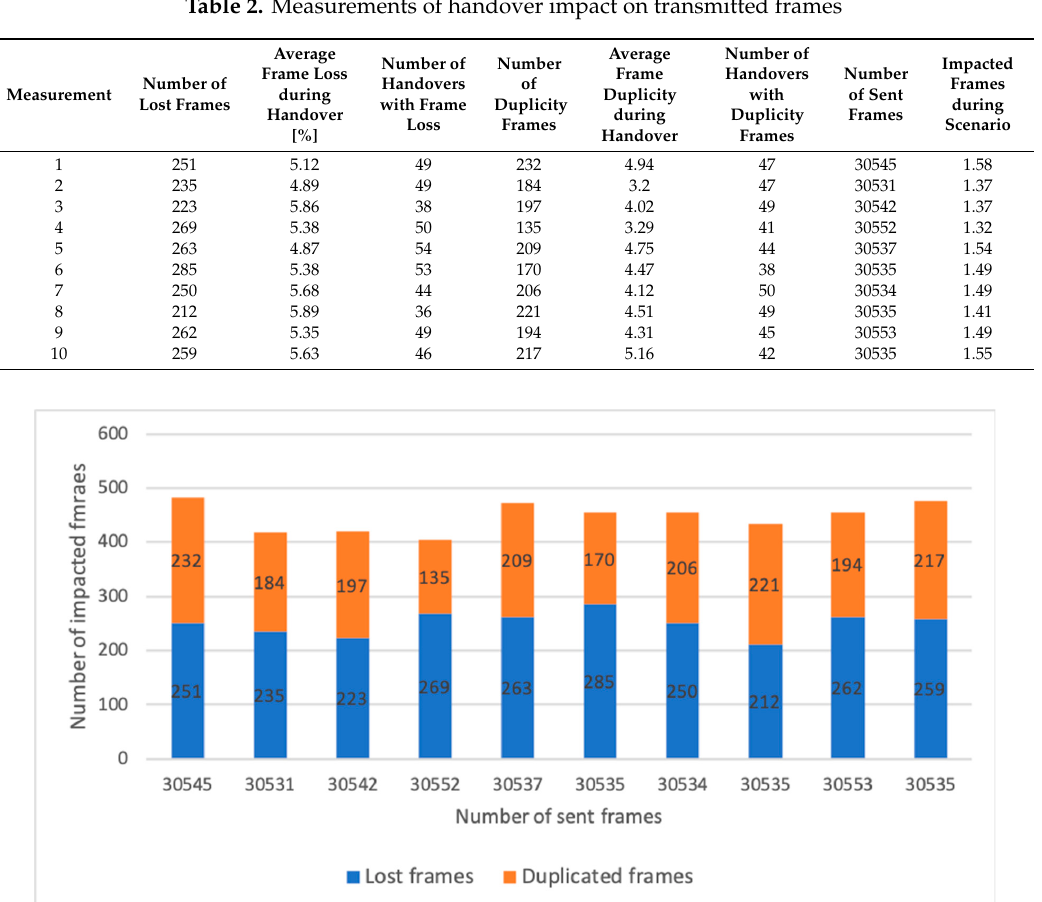
Table 2. Measurements of handover impact on transmitted frames